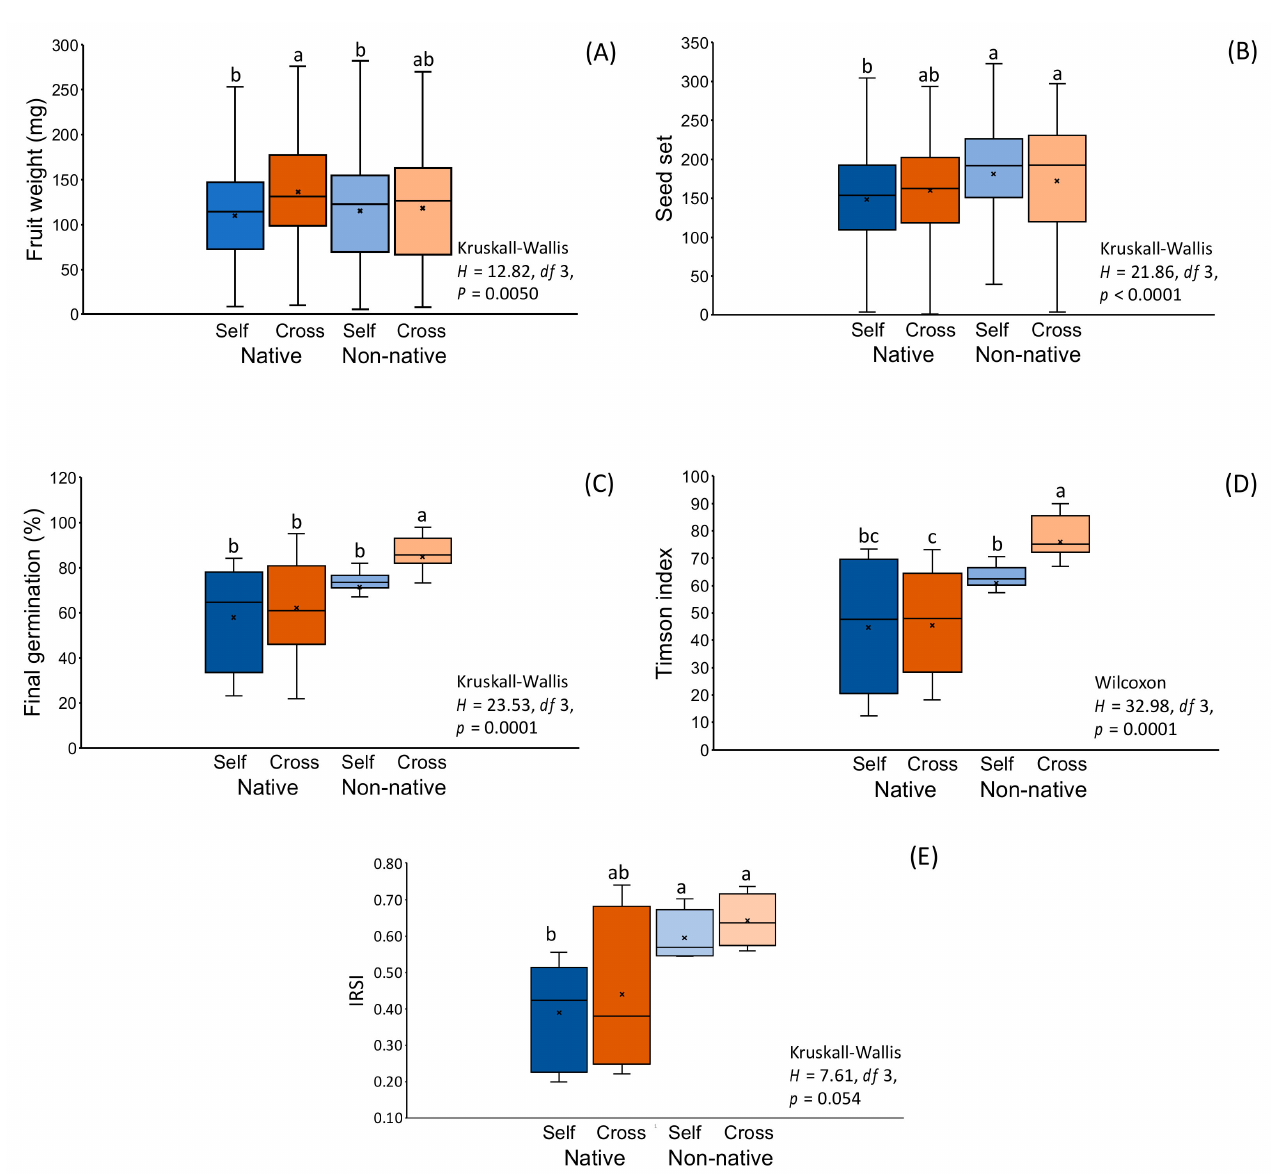
Figure 4. Comparison between groups of native and non-native populations of Oenothera drummondii of the characteristics of fruit weight ( A ), seed set ( B ), final and rate germination ( C , D ) and the integral reproductive success (IRSI) ( E ), obtained by self- (Self) and cross-pollination (Cross). The result of the Kruskal–Wallis nonparametric ANOVA is shown on each graph. Different letters above the boxes indicate significant differences (Steel–Dwass all pairs multiple comparisons, p < 0.001). Boxes show the average (x), median (-) and